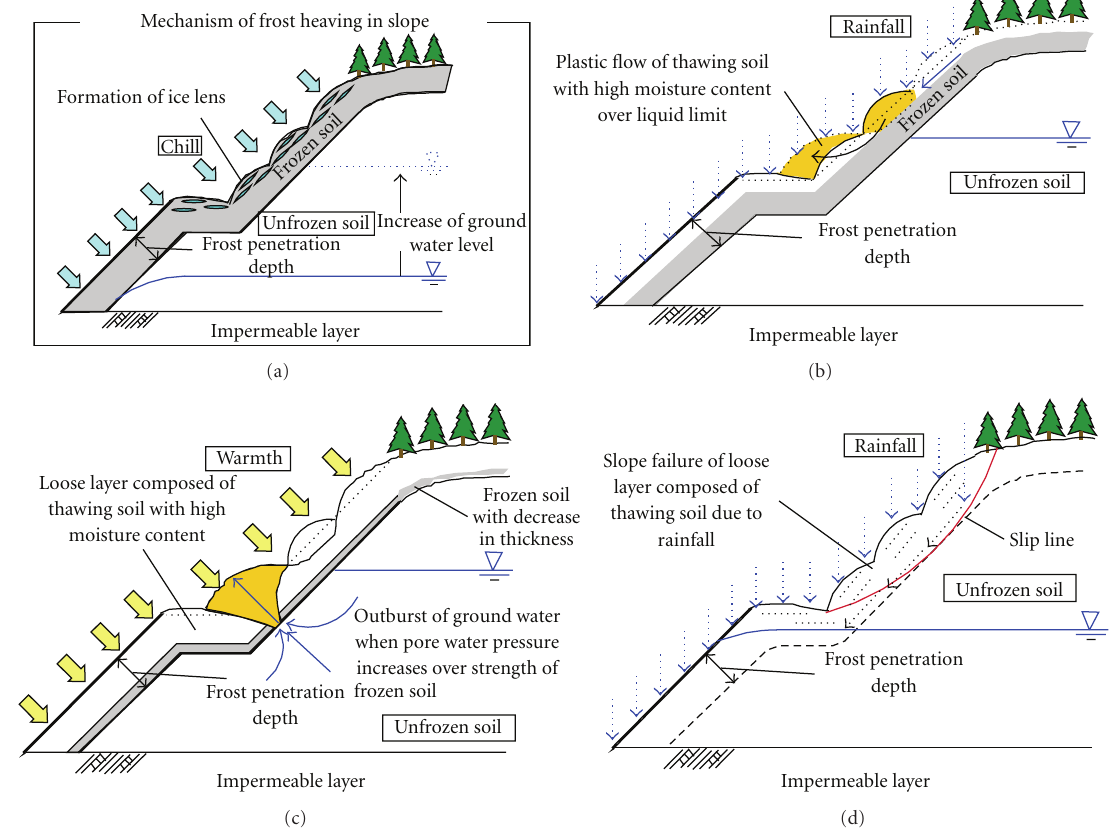
Figure 1: Mechanism of frost heaving in cut slope observed for cold regions and failure modes. (a) Mechanism of frost heaving in slope, (b) surface failure of thawing soil with high moisture content over liquid limit, (c) slope failure due to piping by increase of pore water pressure, and (d) slope failure of loose layer composed thawing soil due to rainfall.